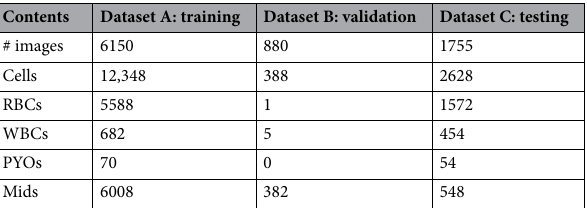
Table 1. Overview of the dataset. The dataset is divided randomly. As some samples are negative, they contain fewer cells.